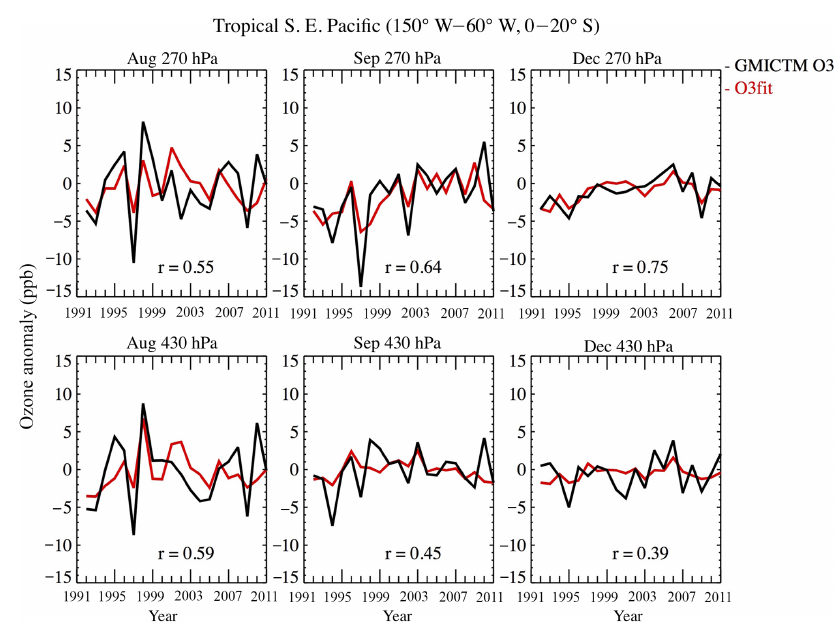
Figure 16. Comparison of the simulated ozone anomalies and the reconstructed ozone anomalies relying on two predictor variables: StratO 3 and EmissO 3 at 270 and 430hPa over the tropical southeastern Pacific. Three panels show results from August (left), September (middle), and December (right) from 1992 to 2011. Unit for y axis is parts per billion (ppb).